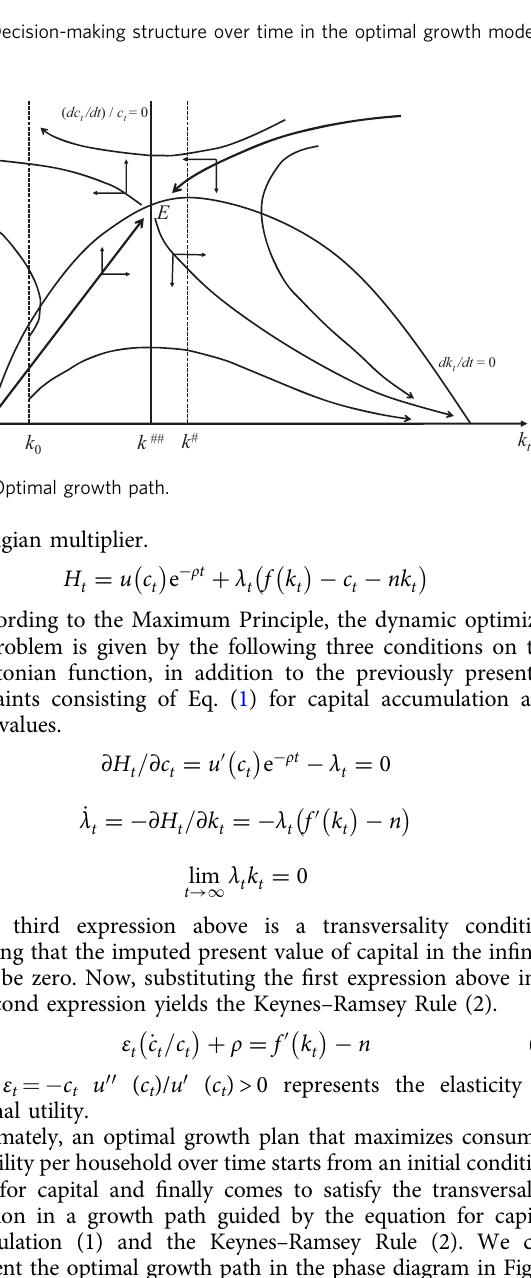
Fig. 1 Decision-making structure over time in the optimal growth